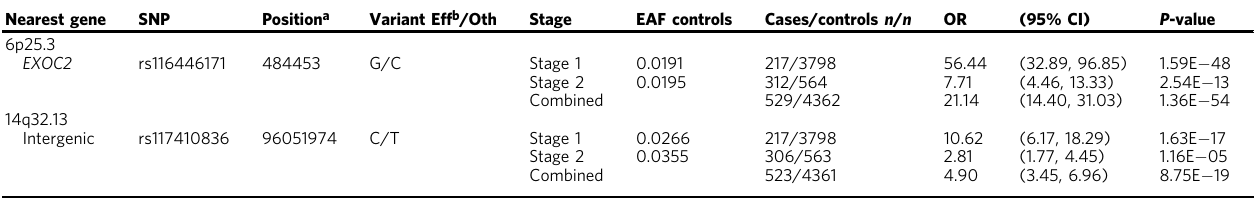
Table 1 Association statistics for two independent SNP genotypes and WM/LPL risk Nearest gene